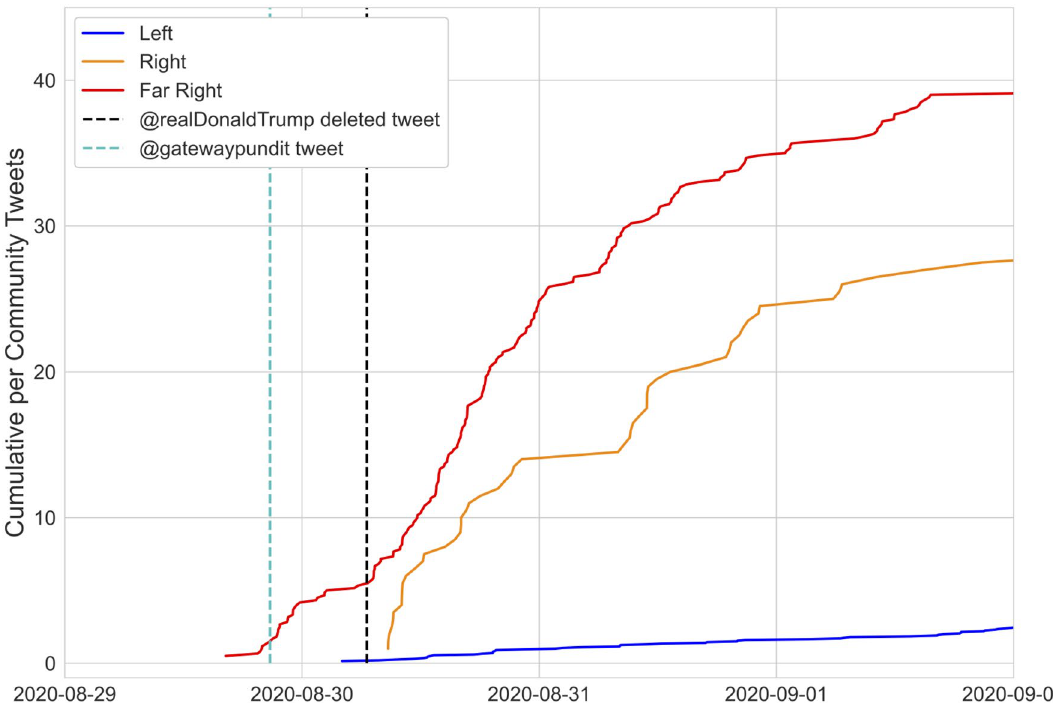
Figure 7. Cumulative per community tweet curves by cluster for tweets discussing the CDC altering its reported COVID-19 death statistics in August of 2020. The cyan dotted line denotes the time of a GatewayPundit tweet that sparked an amplification event in the Far Right and the black dotted line denotes the time of a deleted Donald Trump retweet of a QAnon account promoting the